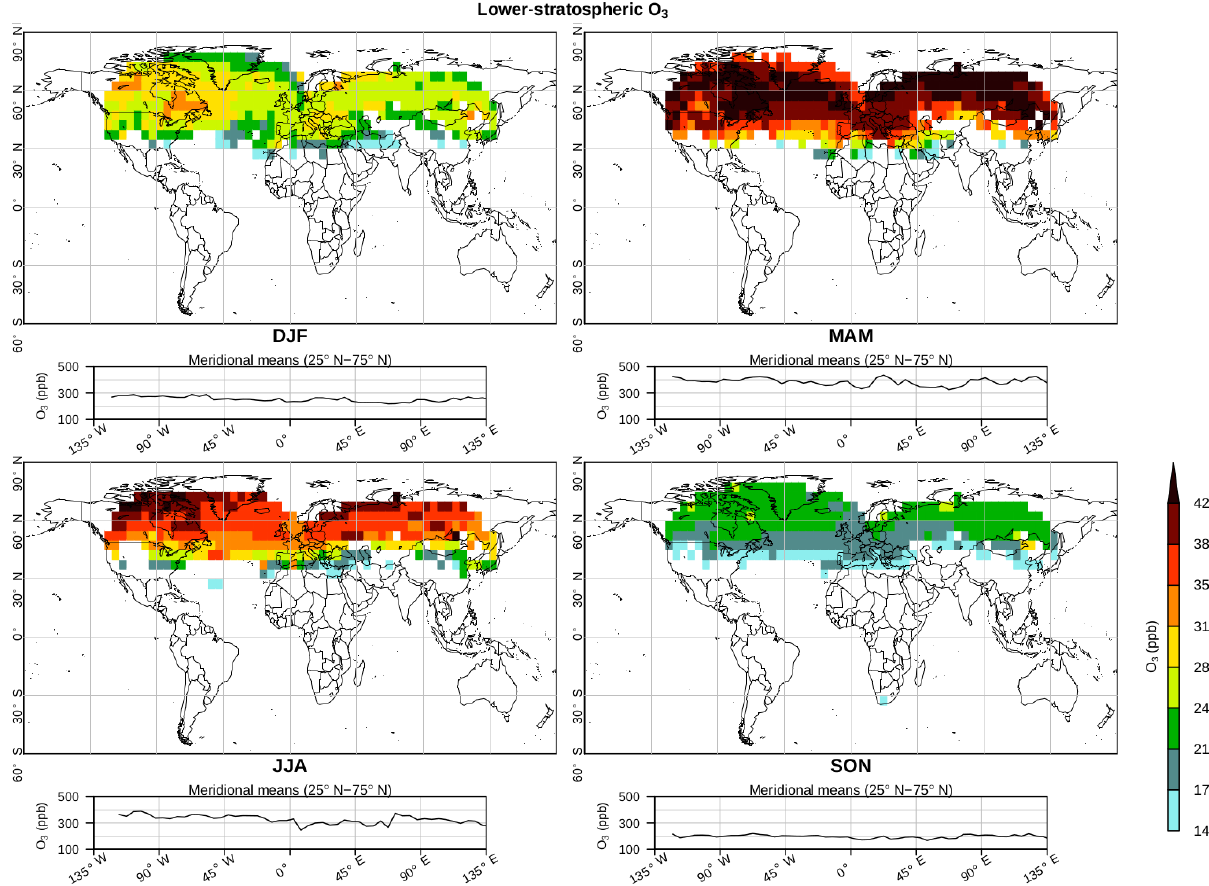
Figure 4. Horizontal distributions of O 3 volume mixing ratios in the LS averaged from December 1994 to November 2013, in every season. Each 2-D distribution is projected onto the zonal axis below, with a meridional average of the northern extratropical zonal band (from 25 to 75 ◦ N). The 2-D (1-D) distributions have a 5 ◦ × 5 ◦ (5 ◦ ) resolution. The x axes are the same in the maps and in the projections below. As explained in Sect. 2.2.1, there are no data in the subtropical